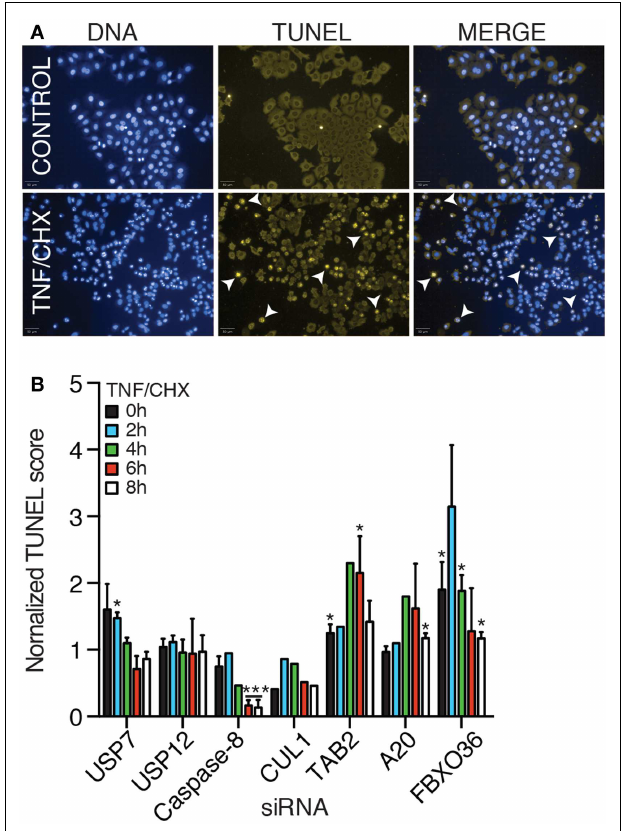
FIGURE 10 | (A) TUNEL and DNA stain of HeLa cells (upper row), or HeLa cells treated withTNF and cycloheximide (CHX) for 8h (lower row). (B) Relative levels of apoptosis in HeLa cells treated with the indicated siRNA duplexes andTNF and cycloheximide for the indicated periods. For each time point, the level of apoptosis in cells treated with non-silencing (NS) siRNA were assigned a value of 1 and other treatments are reported relative to the control. (B) Results are the mean of three separate experiments and error bars indicate the standard deviation. Statistical analysis was performed with a one-way ANOVA analysis, and one and three asterisks indicate p values below 0.05 and 0.001, respectively.